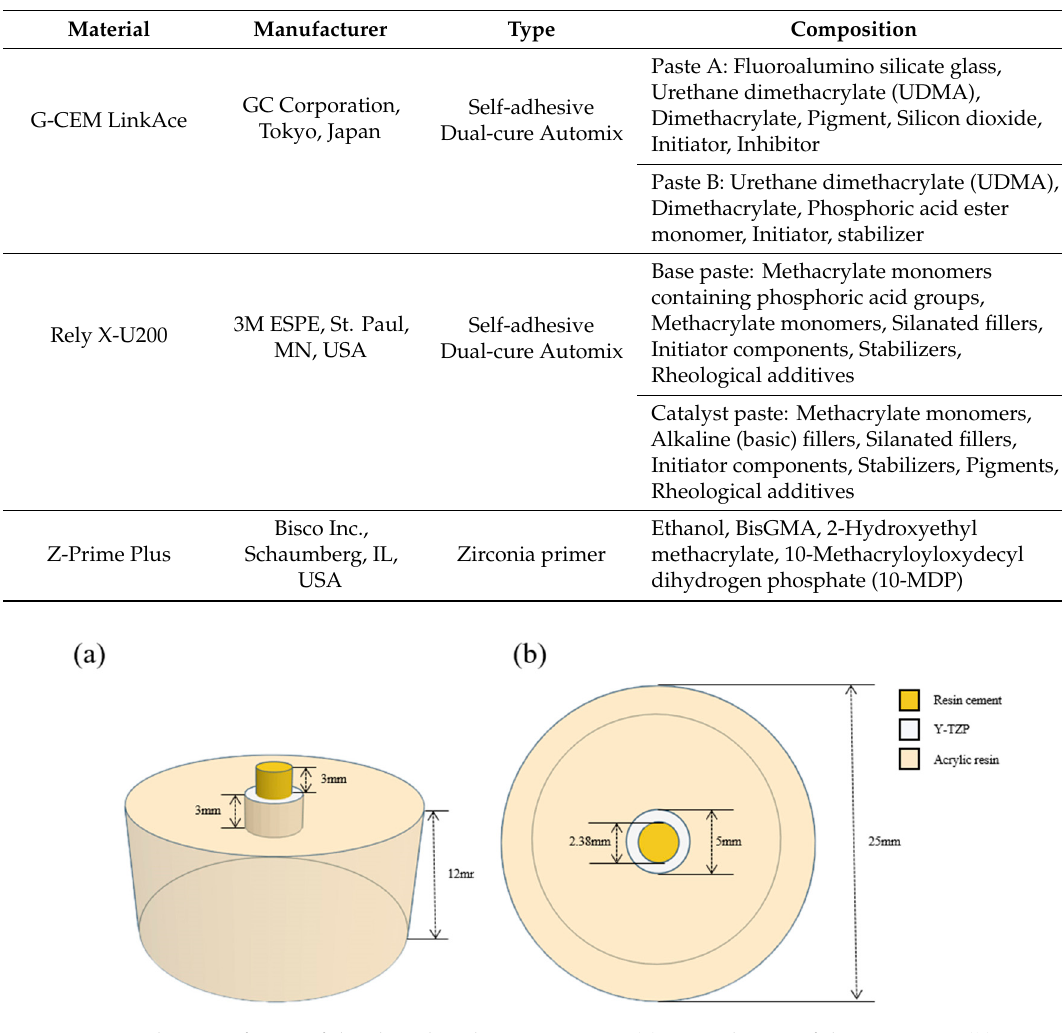
Figure 4. Schematic figure of the shear bond test specimen. ( a ) Frontal view of the specimen; ( b ) Top view of the specimen.